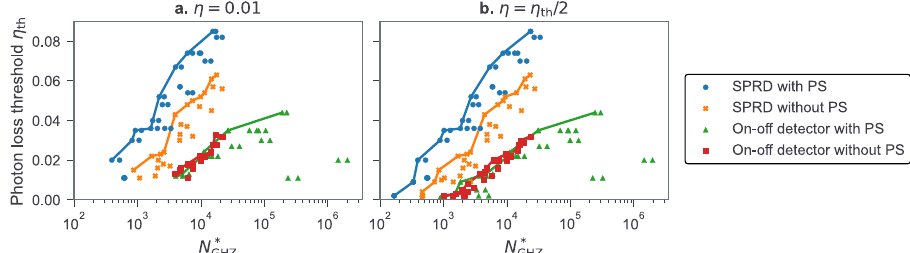
Fig. 6 Photon loss threshold η th of PTQC as a function of the average number N (cid:1) of GHZ-3 states per central qubit. N (cid:4) is calculated at GHZ GHZ η = 0.01 in ( a ) and η = η th /2 in ( b ). The data points correspond to different parameter settings on the type of detectors, the post-selection (PS) of star clusters, the encoding size, and the H -con fi guration, which are grouped by the fi rst two factors. “ SPRD ” stands for single-photon resolving detector. In ( a ), only data points with η th > 0.01 are presented. The upper envelope for each of the groups is presented as a line. The values of j are chosen to maximize η th .